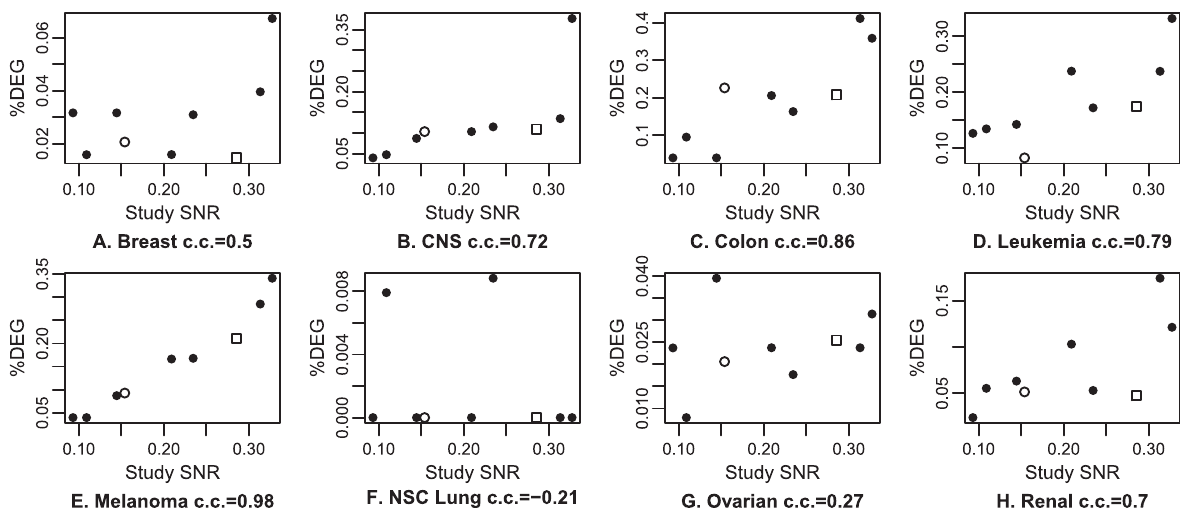
Figure 1. Link between statistical significance and study SNR in NCI60 datasets. Statistical significance is estimated as the fraction of differentially expressed genes (%DEG) between a cancer type and the other cancer types, each panel representing a different cancer type. Higher SNR leads to higher %DEG, as expected. . are on Affymetrix platforms (GSE5720 and GSE5949), 0 is on NCI dual channel (GSE2003) and % is on Stanford dual channel (GSE7947). c.c. are correlation coefficients.